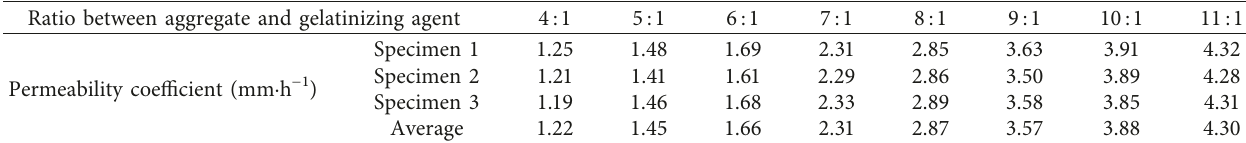
Table 3: Permeability coefficient of each experimental material. Ratio between aggregate and gelatinizing